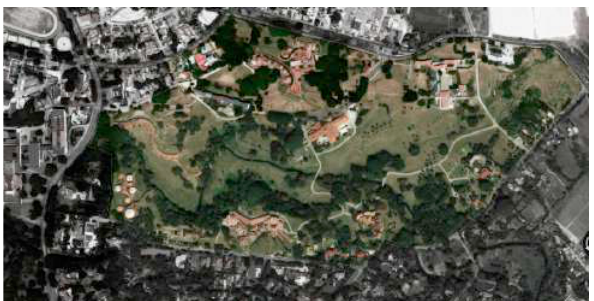
Figure 1. National Art Schools of Havana